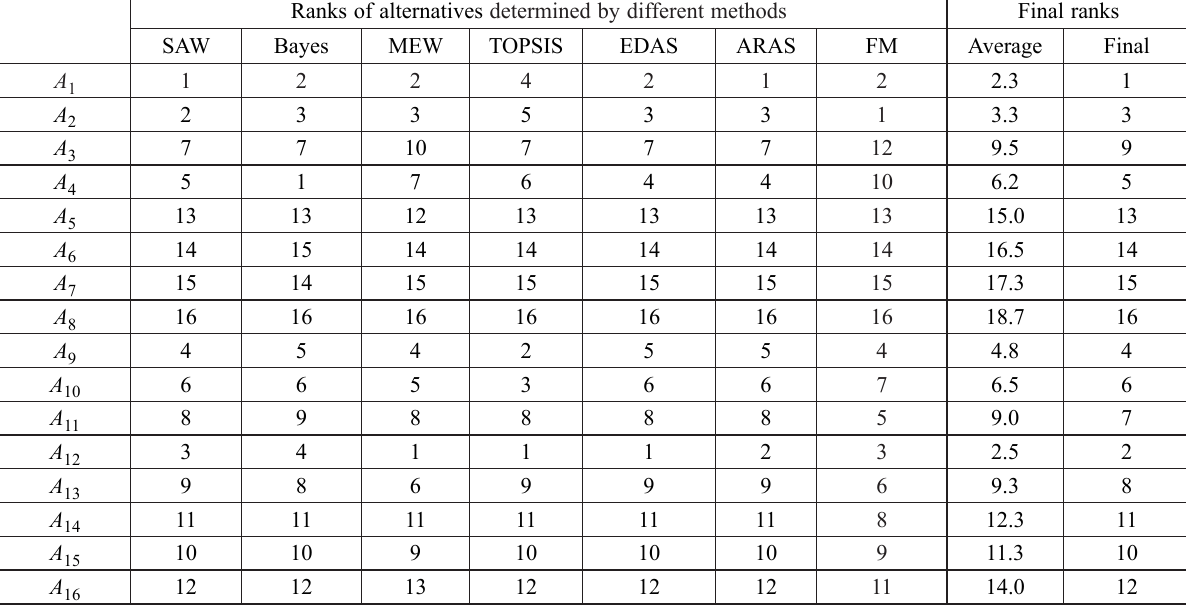
Table 5. Ranking of alternatives when criteria weights are considered Ranks of alternatives determined by different methods Final